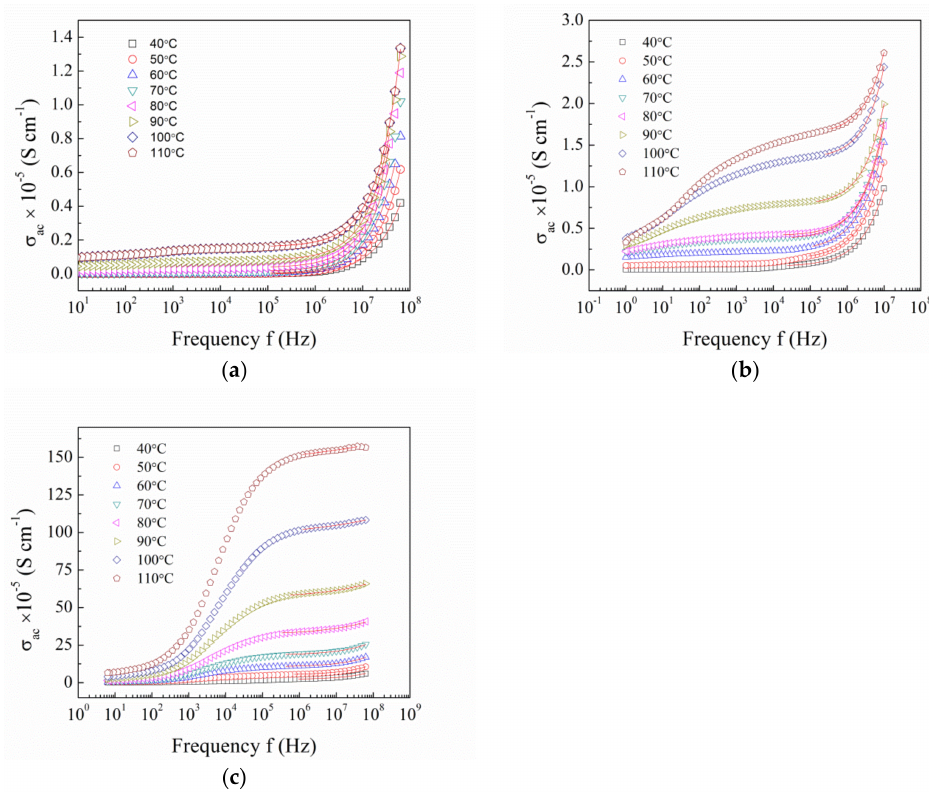
Figure 4. The frequency dependent of ac conductivity of the PVA ( a ), PVA/LiCl film ( b ) and PVA/AgNO 3 films ( c ) at different temperatures from (40–110 ◦